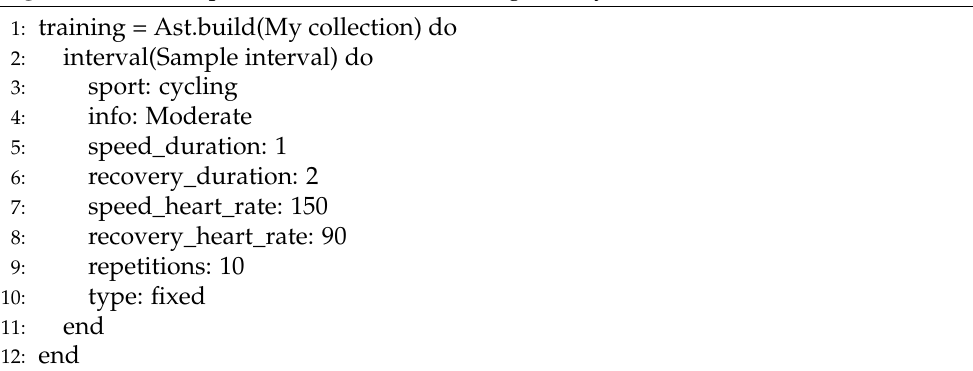
Algorithm 4 Description of the interval training in